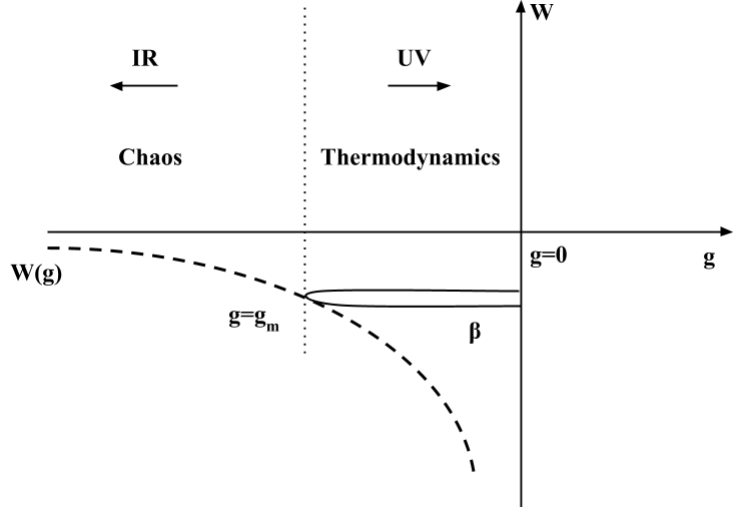
Figure 2 . The (cid:12)gure depicts the scattering of a particle from the potential W ( g ). The total time it takes for the particle to return to the origin de(cid:12)nes (cid:12) . Increasing (cid:12) corresponds to scattering the particle with a higher energy and the particle penetrates deeper into the g < 0 region. The thermodynamic quantities are determined by the potential in the region g m (cid:20) g (cid:20) 0 while the Lyapunov exponent is determined by the potential in the region g (cid:20) g m